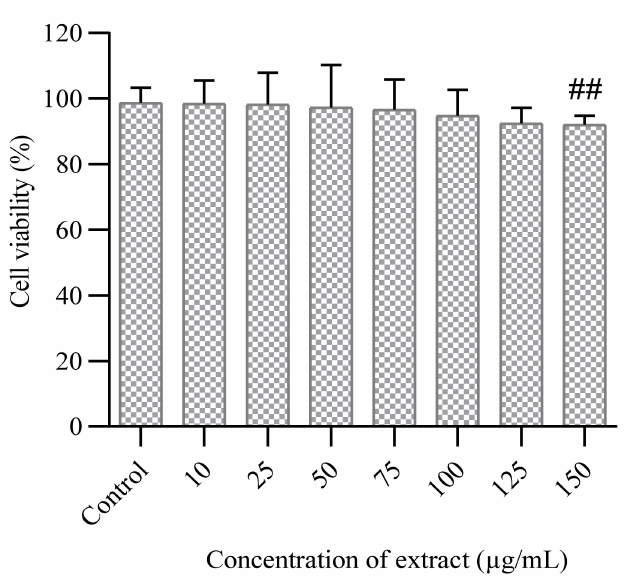
Figure 1. Cytotoxic effect of PUFA-rich extract from Chlorella sp. S14 on normal neuronal brain (HT-22) cells. Bars represent mean ± SEM. Values are statistically different at ## p < 0.05 vs.